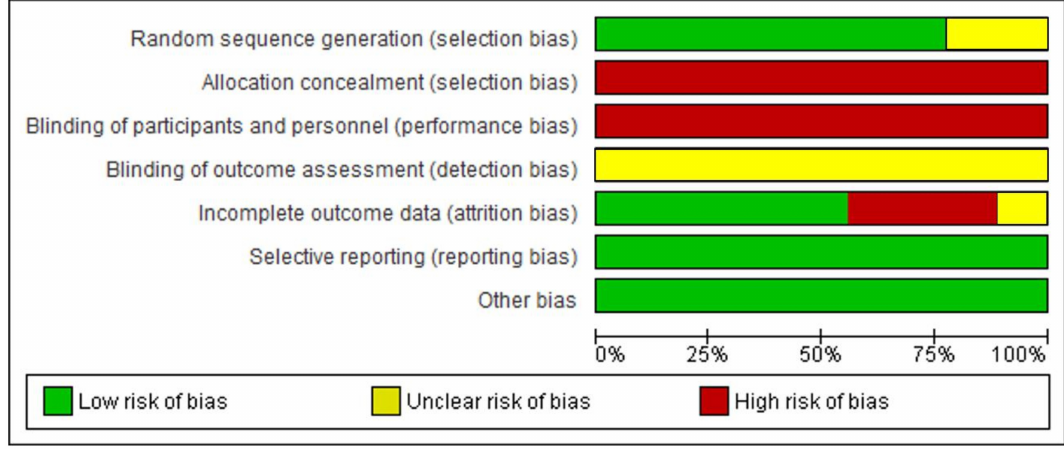
Figure 2. Graph showing risk of bias: percentages are provided for all studies included, based on a review of authors’ opinions about each risk of bias